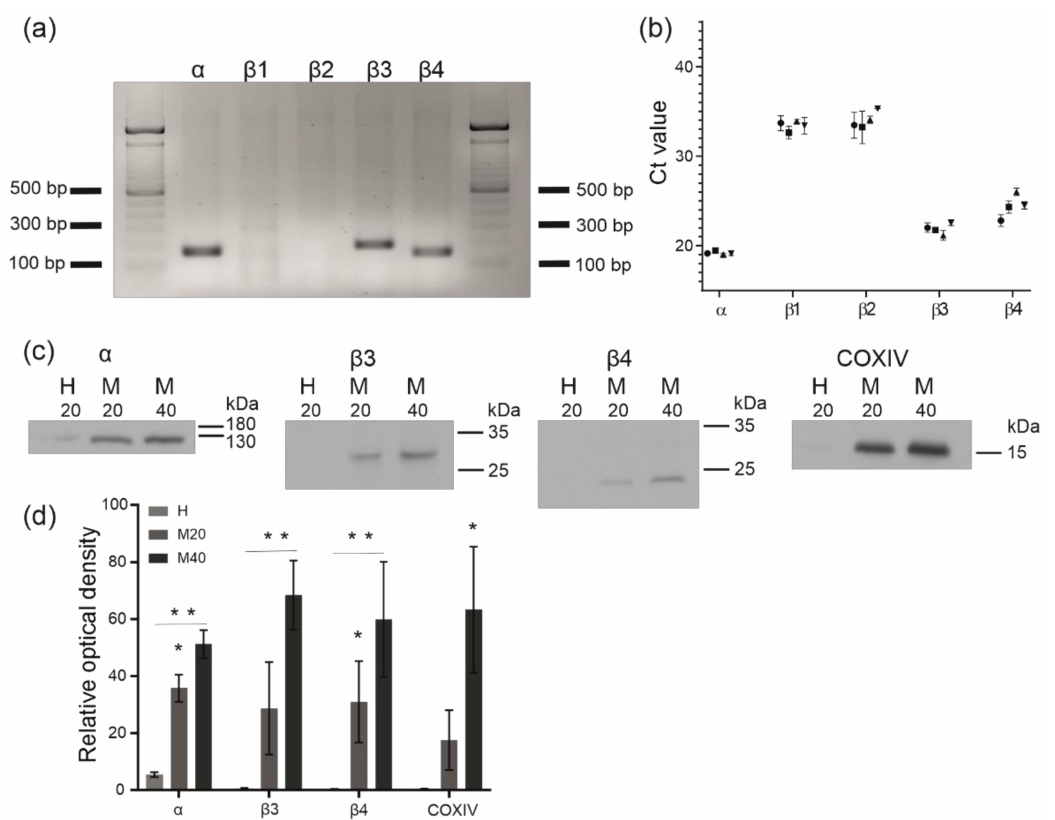
Figure 6. Analysis of gene expression and the immunodetection of the BK Ca channel α pore forming and auxiliary β subunits. ( a ) PCR amplification of BK Ca channel subunits. α , Product of the amplification of KCNMA1 gene ( n = 3); β 1–4, products of the amplification of transcripts encoded by KCNMB1-KCNMB4 ( n = 3). ( b ) qPCR detection of the BK channel subunits; Ct: cycle threshold; ( n = 4). ( c ) Representative images of immunostaining for BK Ca channel subunits. Western blot analysis of proteins from the cell homogenate (H; 20 µ g of total protein) and mitochondrial fractions (M at two concentrations, 20 µ g and 40 µ g), loaded into each lane ( n = 3). ( d ) Quantification of band intensities was performed using ImageJ software. The number of Western blots analyzed was three per group. p < 0.05 (*), p < 0.01